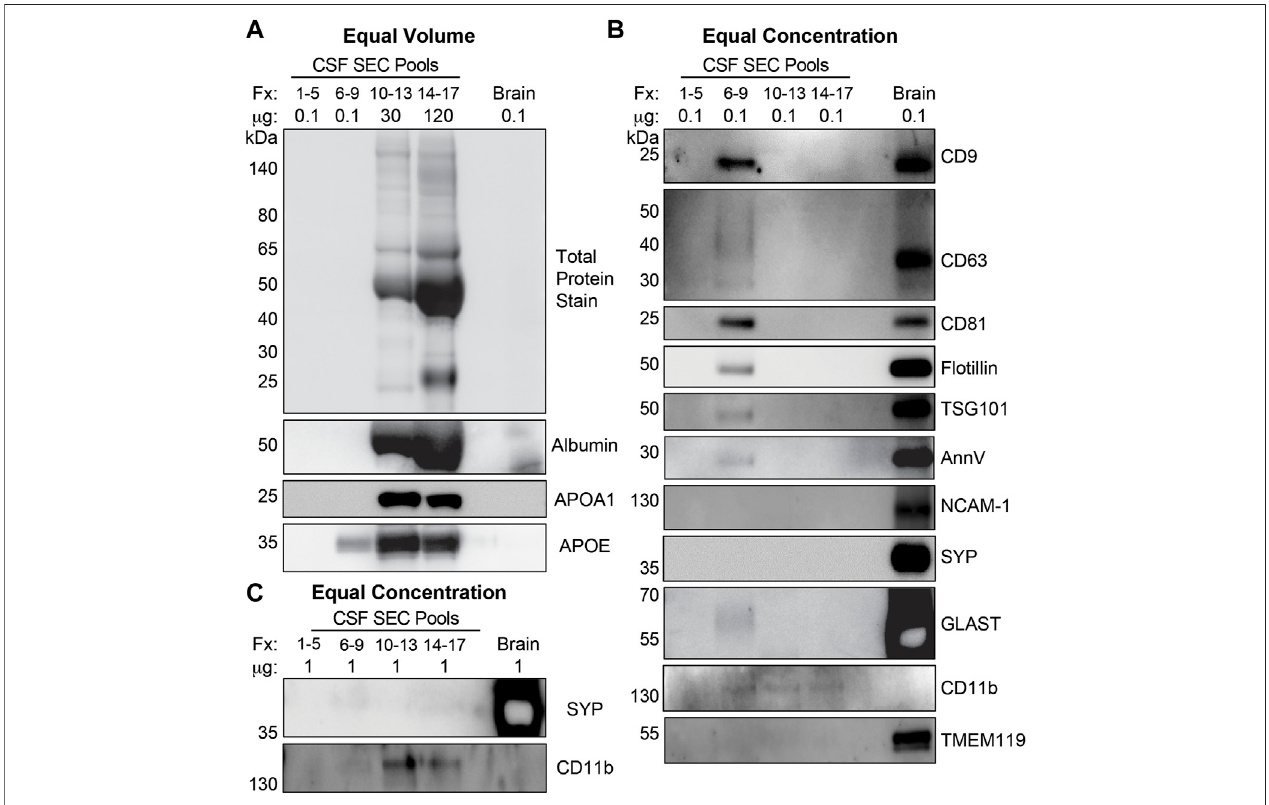
FIGURE 5 | CSF EVs isolated by SEC are enriched for exosome and MV markers. (A) Equal volume loading of protein lysate (37 µL) from pools of SEC Fractions (Fxs):1 – 5(columnvoidvolume),6 – 9,10 – 13,and14 – 17stainedfortotalprotein,andimmunoblottedforalbumin,APOA1,andAPOE. (B) Equalconcentrationloadingof proteinlysate(0.1 µg)frompoolsofFxs1 – 5,6 – 9,10 – 13,and14 – 17immunoblottedforCD9,CD63,CD81, fl otillin,TSG101,AnnV,SYP,NCAM-1,GLAST,CD11b,and TMEM119. (C) Equal concentration loading of (1 µg) from pools of Fxs 1 – 5, 6 – 9, 10 – 13, and 14 – 17 immunoblotted for SYP and CD11b. Postmortem human cerebral cortex protein lysate (0.1 µg and 1 µg) was run as a positive control for each gel ( (A-C) :